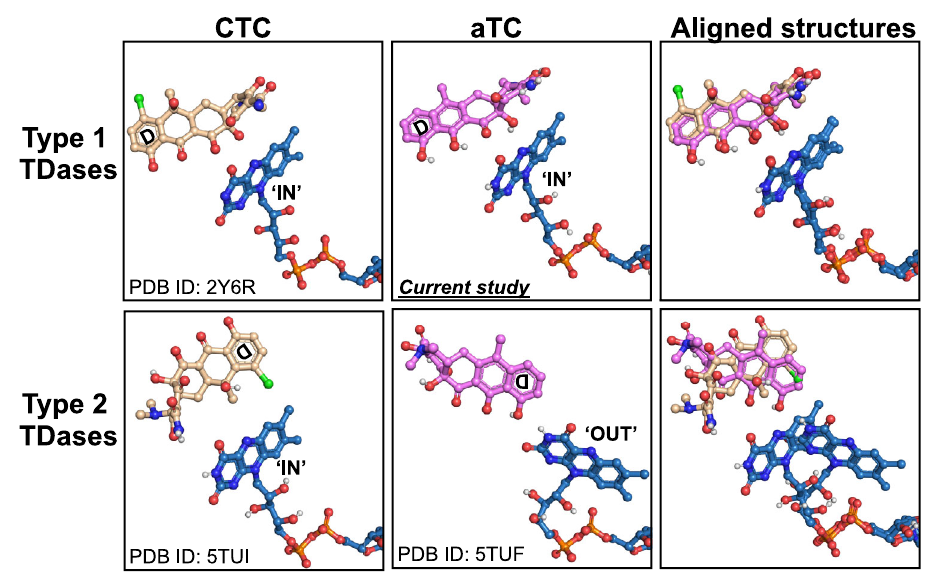
Fig. 6 Substrate and inhibitor binding modes in type 1 and type 2 TDases. In type 1 TDases (top panels), chlortetracycline (CTC) and anhydrotetracycline (aTC) bind in a similar substrate-like orientations. The bound co-factor, FAD (shown in blue) occupies an “ IN ” orientation. In contrast, CTC and aTC bind in distinct orientations in type 2 TDases (bottom panels). Anhydrotetracycline (aTC) locks FAD in an inactive “ OUT ”